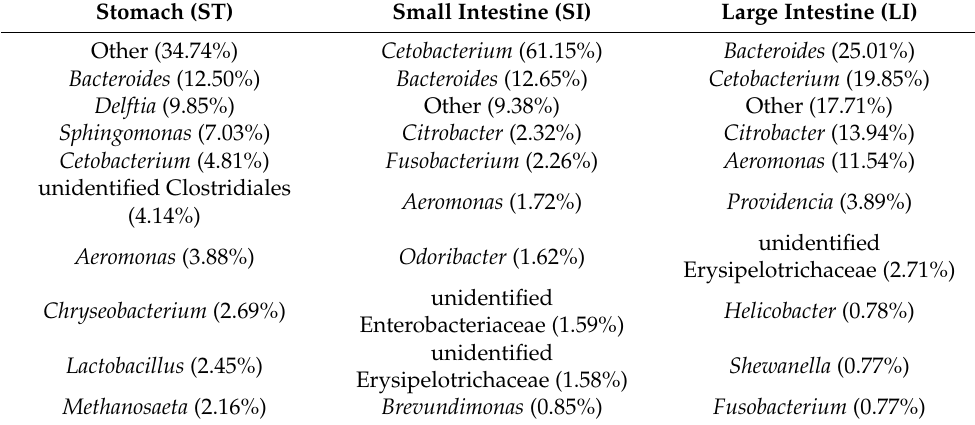
Table 2. The top 10 bacterial genera in different segments of the digestive tract of Lycodon rufozonatus